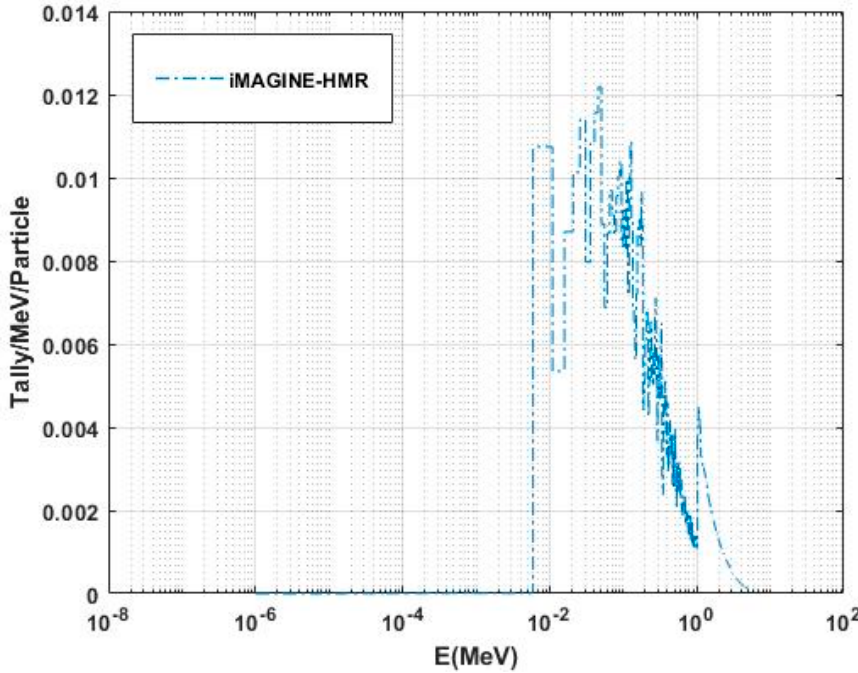
Figure 7. Neutron fluxenergy spectrum for iMAGINE–HMR salt fuel system.